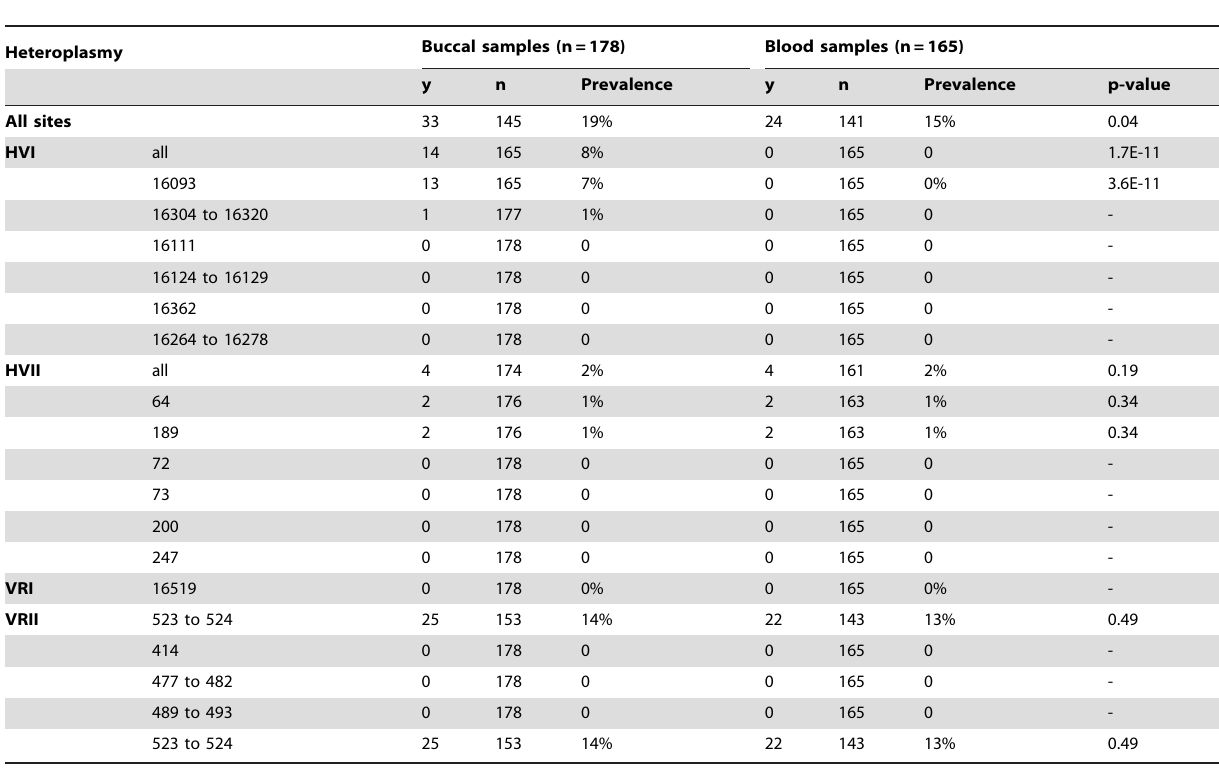
Table 2. Prevalence of control region heteroplasmy in mtDNA for buccal swab and blood tissue samples taken from the same individuals.